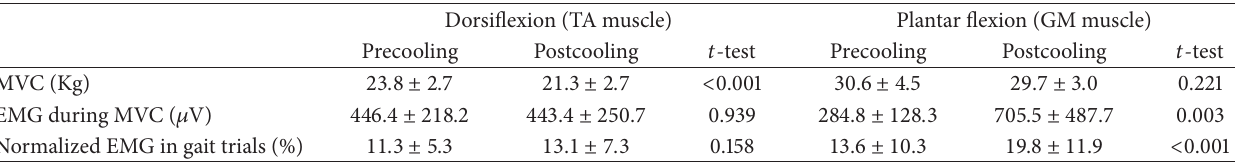
Table 1: The means and standard deviations (mean ± SD) of the three MVC trials as well as the mean EMG amplitude during the three MVC trials and normalized mean of the three median EMG values from the three gait trials are given for the TA and GM muscles before and immediately after cooling ( 𝑛 = 16 ).